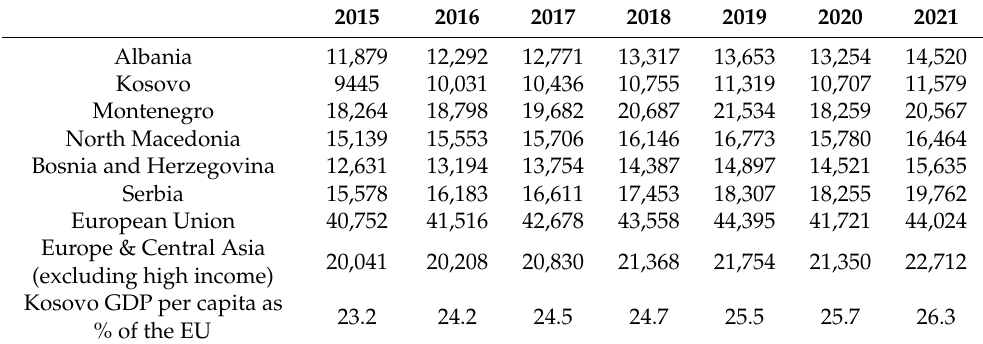
Table 1. GDP per capita, Purchasing Power Parity (constant 2017 international